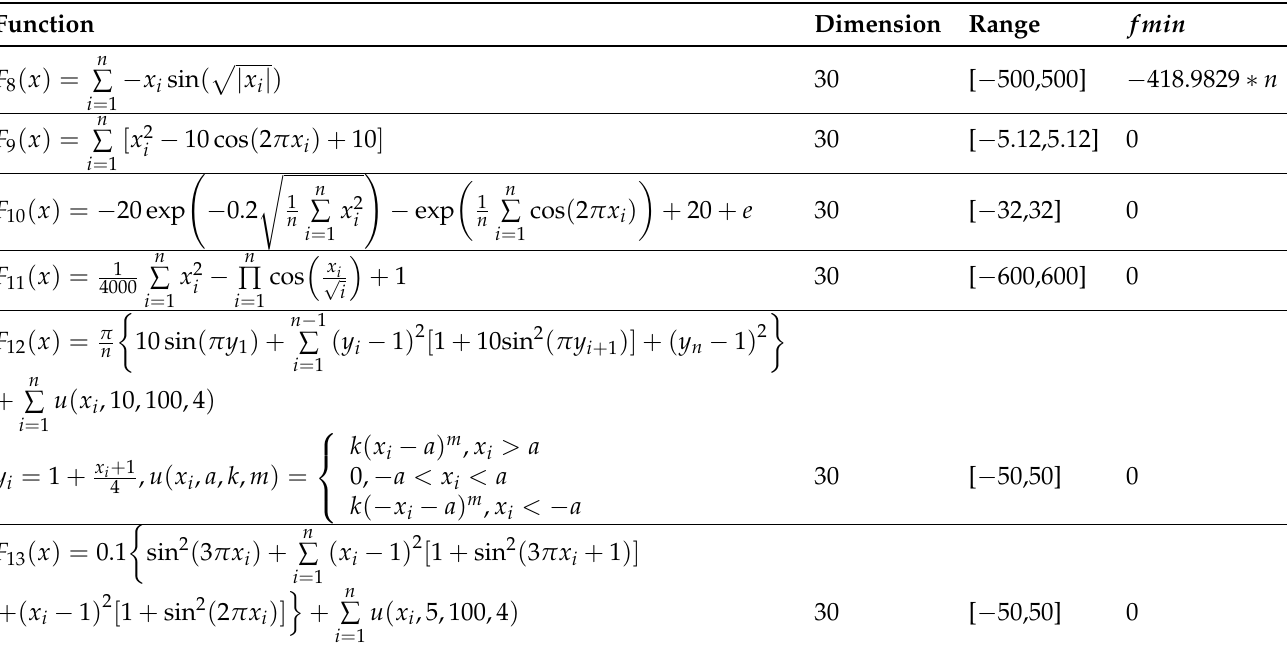
Table A2. Information on multimodal benchmark